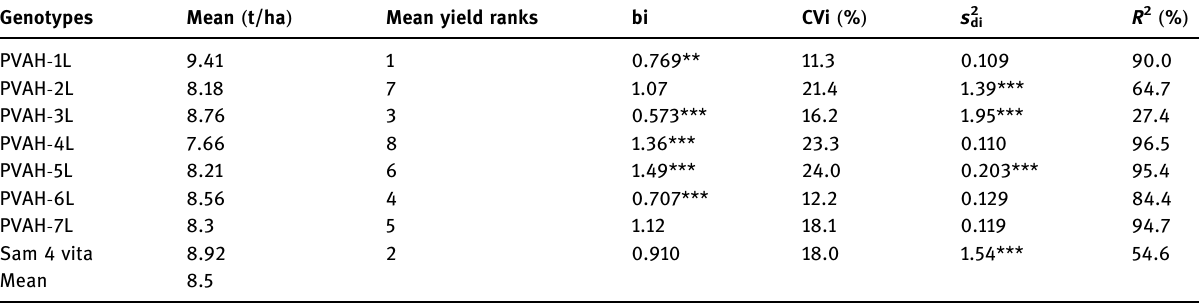
Table 3: Adaptability and stability parameters of eight provitamin A maize genotypes by the Eberhart and Rusell ’ s model